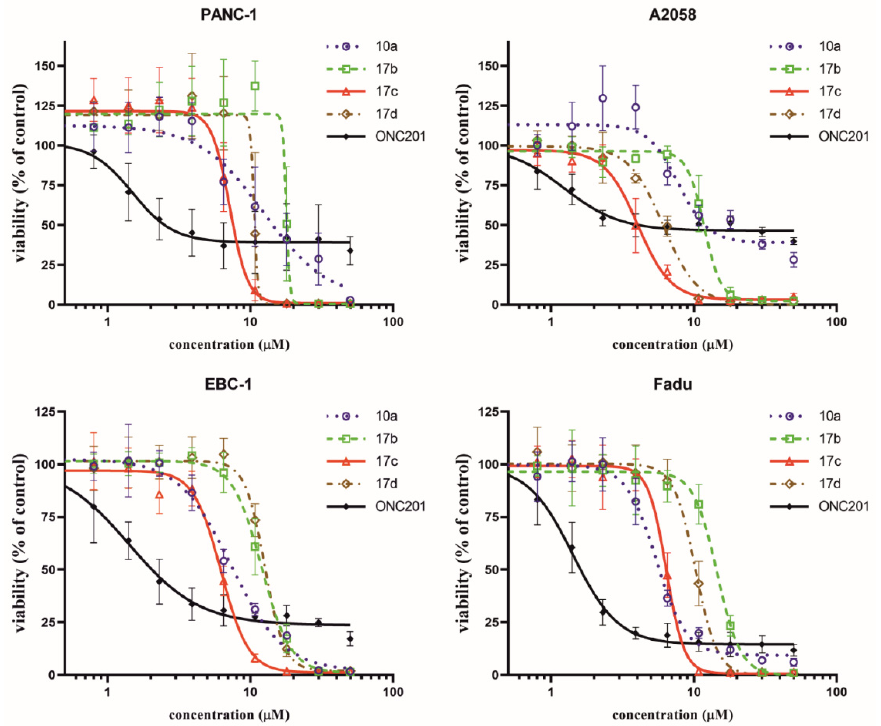
Figure 2. Dose–response curves of selected imipridone hybrids ( 10a , 17b , 17c and 17d ) and reference compound, ONC201, on different cancer cell lines based on MTT cell viability assay. Curves were fitted by GraphPad Prism 8 software using nonlinear regression (variable slope; 95% CI; n = 4). Table 2. IC 50 values (µM) of selected imipridone hybrids ( 10a , 17b , 17c and 17d ) and reference com- pound, ONC201, after 72 h of treatment, based on MTT assay. IC 50 values were determined by GraphPad Prism 8 software (nonlinear regression; variable slope; best-fit values; n = 4). Treated Cells